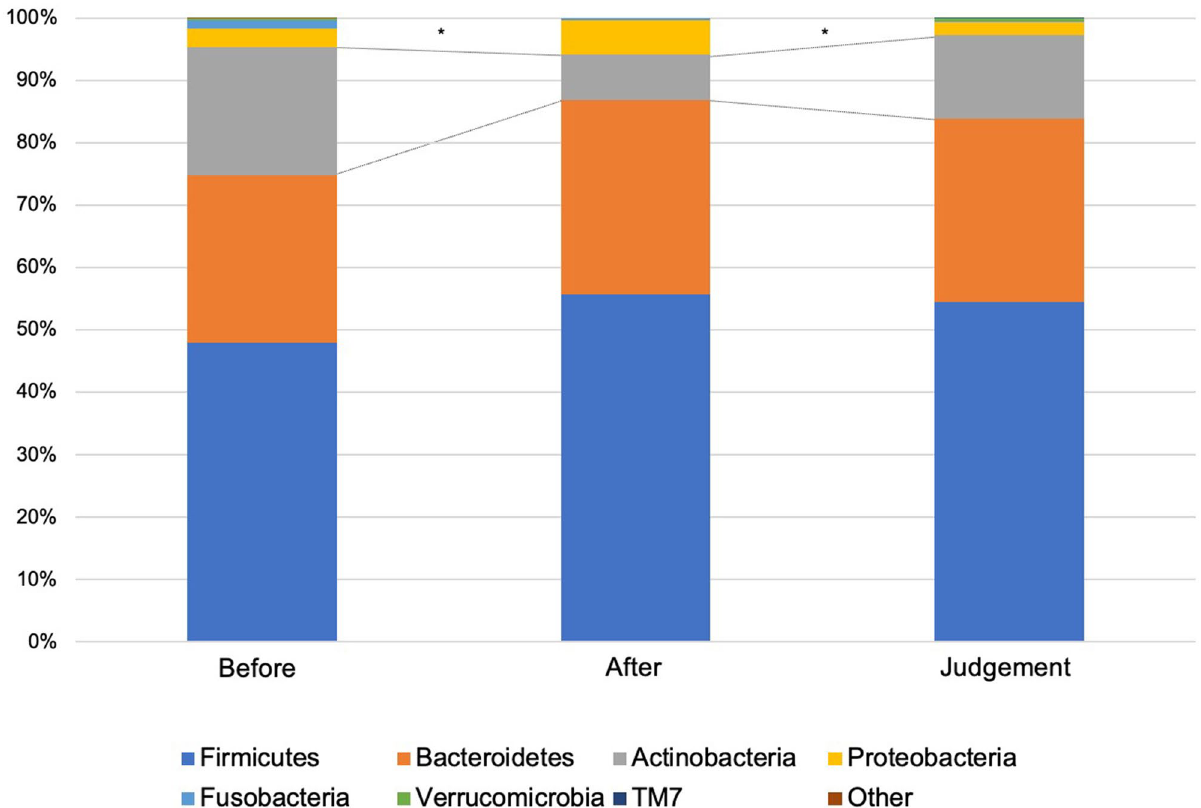
Figure 2. Relative abundance of the intestinal microbiota at the phyla at the following three time points: before eradication therapy, after eradication therapy, and at the time of eradication therapy